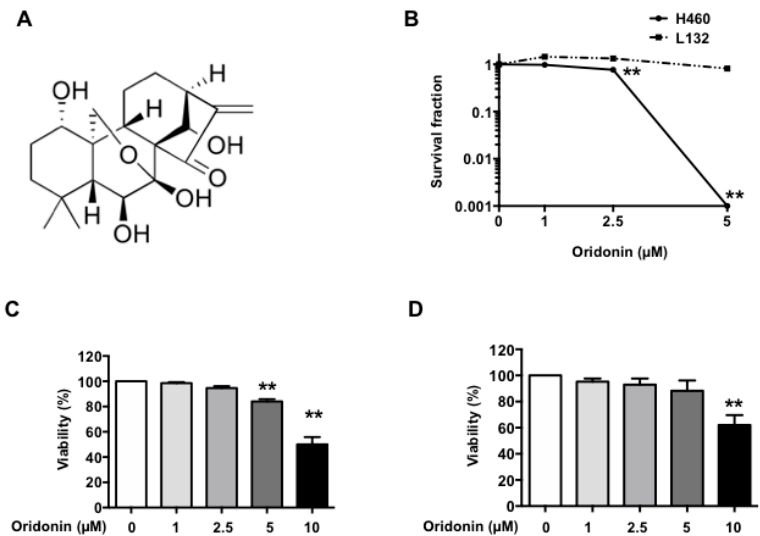
Figure 1. The cytotoxic effect of oridonin on human lung cancer cells and non-cancer cells. ( A ) Molecular structure of oridonin; ( B ) survival fractions obtained by colony forming assay. H460 cells and L132 cells were incubated for 7 days in the presence of 0 µM to 5 µM oridonin. MTT (3-(4,5-dimethylthiazol-2-yl)-2,5-diphenyltetrazolium bromide) assay in H460 cells ( C ) and L132 cells ( D ). Cells (5 × 10 3 ) were seeded into 24-well plates and incubated for 48 h in the presence of 0 µM to 10 µM oridonin. All experiments were independently performed three times. The data are shown as means ± SEM; ** p < 0.01 versus 0 µM oridonin.